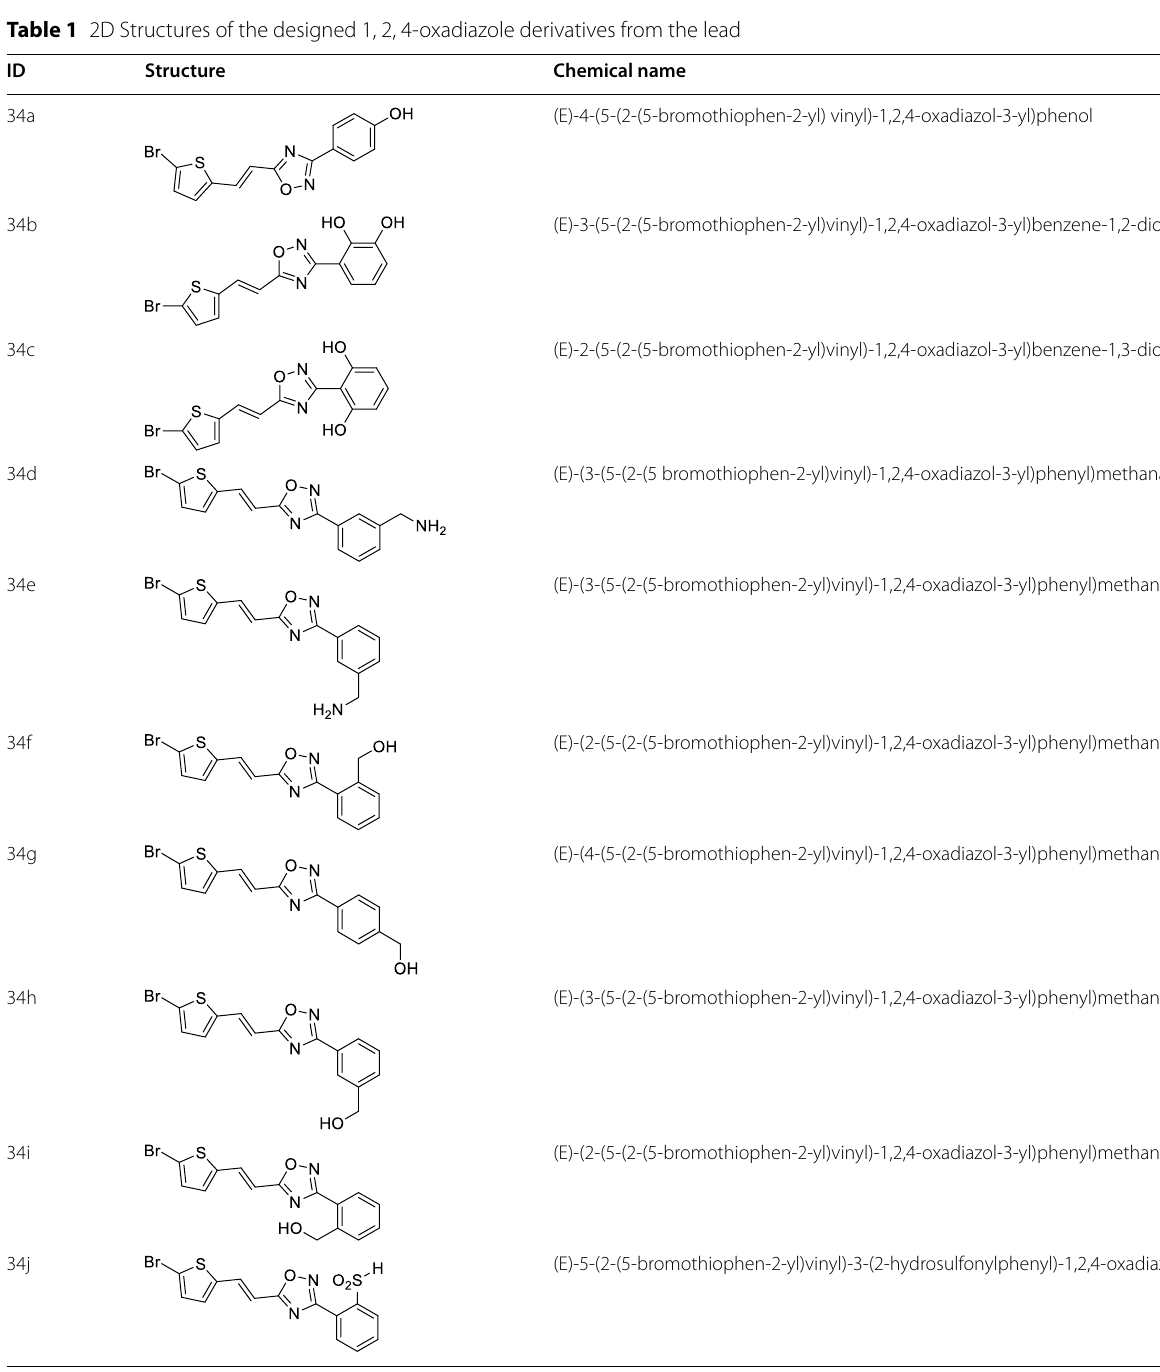
1a–j and 3a–f, whereas those of the co-crystal ligand of the protease before and after docking are presented in Additional file 1: Fig. SF2a, b, respectively.